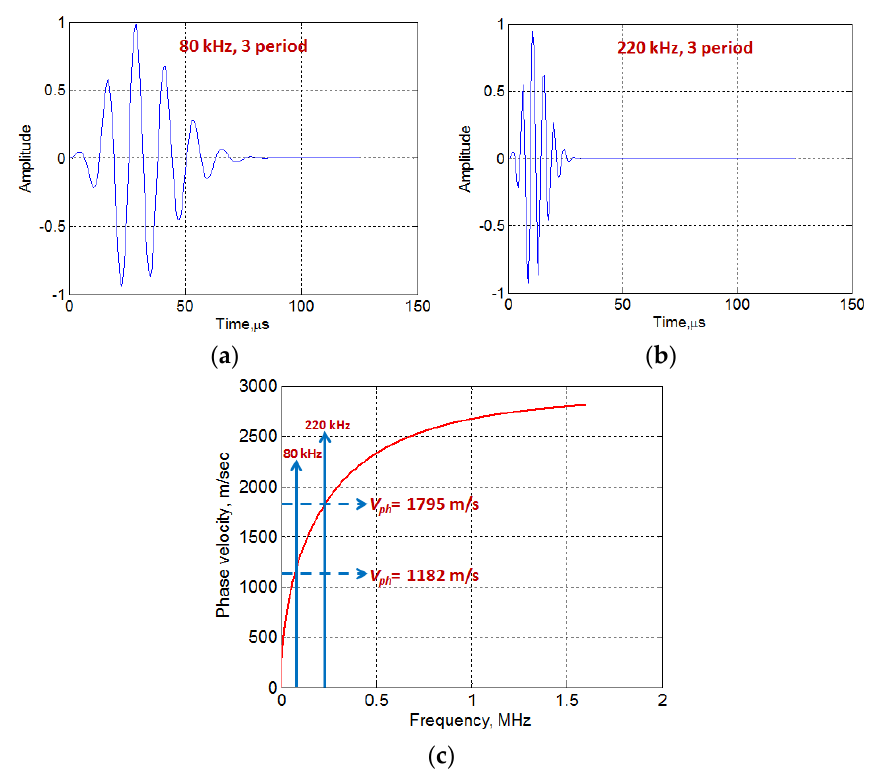
Figure 4. 80 kHz, 3 period ( a ) and 220 kHz, 3-period excitation signals ( b ) with Gaussian symmetry and the phase velocity dispersion curve of the A0 wave mode in 2 mm Al alloy plate ( c ). Hence, the wavelength ( λ 80 and λ 220 ) and a number of wavelengths ( N λ 80 and N λ 220 ) along the length and under the region of MFC transducer at 80 kHz and 220 kHz frequencies can be calculated by using Equations (3) and (4).